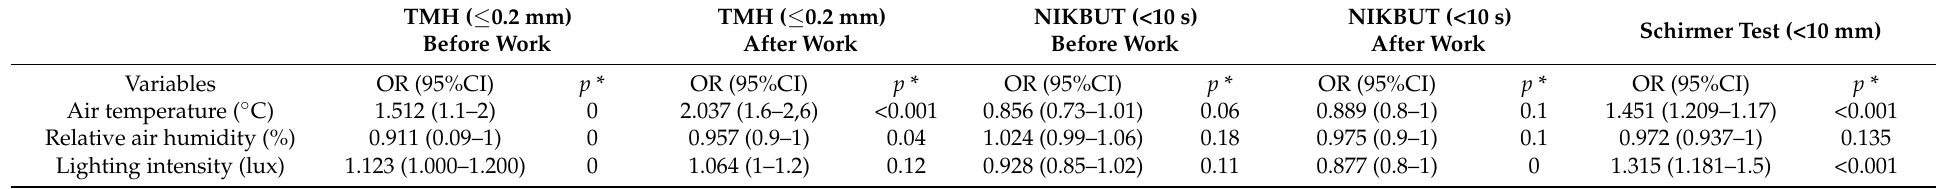
Table 4. Univariable logistic regression to determine the influence of temperature, relative air humidity, and lighting intensity on the incorrect results of the eye surface parameters.